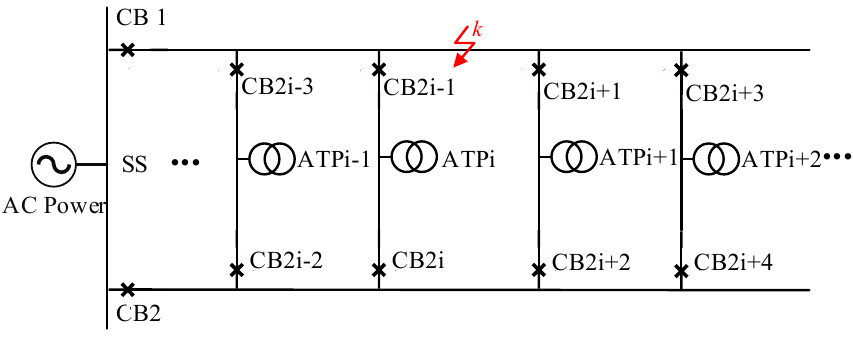
Figure 6. Single-line diagram of AARS.